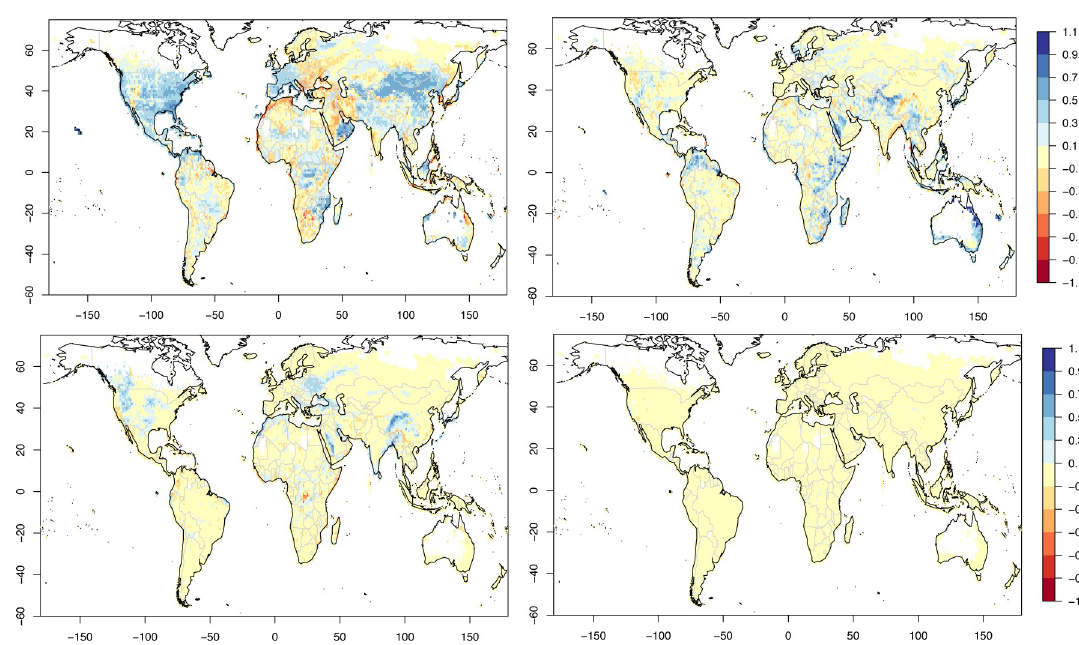
Fig 5. Maps of GCP-PC prediction departures. Changes in prediction expressed as the difference between the individual absolute departures from the actual GCP-PC values for step ‘n-1’ minus step ‘n’ for the global case. A positive (negative) value means that the additional predictor is improving (deteriorating) the prediction. Top left: Change from step 1 to 2. Top right: Change from step 2 to 3. Bottom left: Change from step 3 to 4. Bottom right: Change from step 6 to 7.